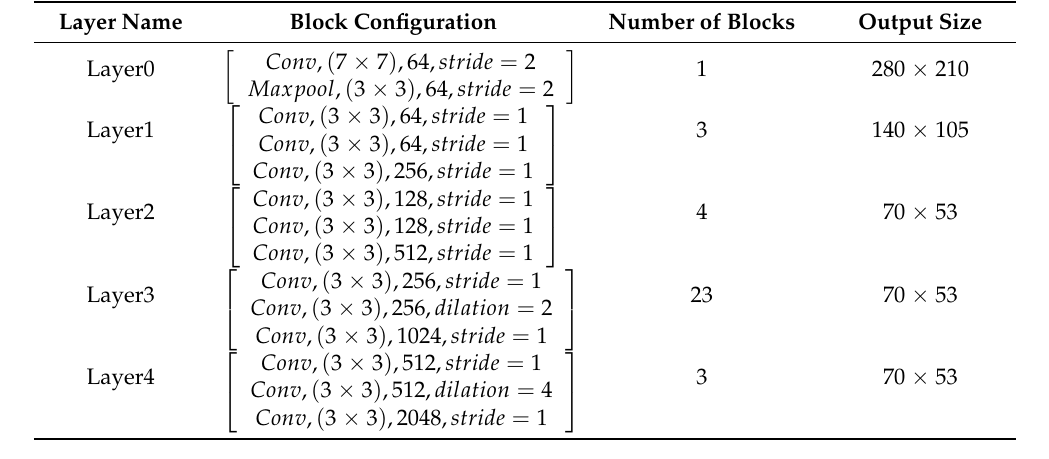
Table 2. Configuration of